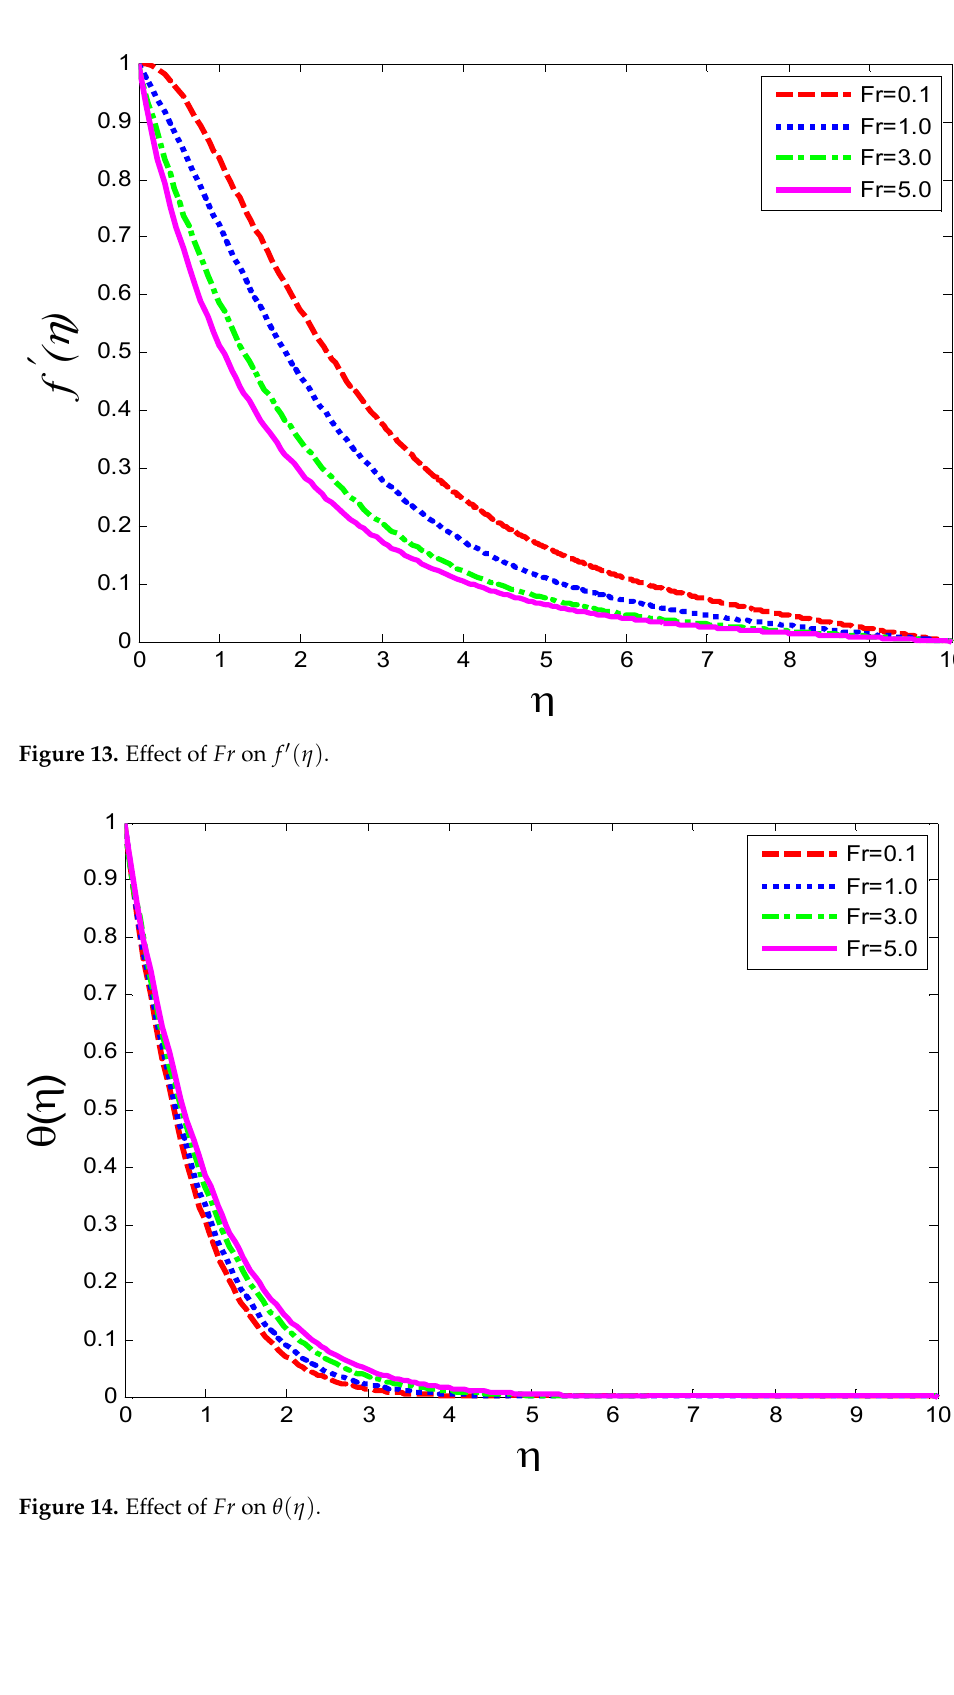
Figure 12. Effect of 𝐾 ∗ on 𝜙(cid:4666)𝜂(cid:4667) .